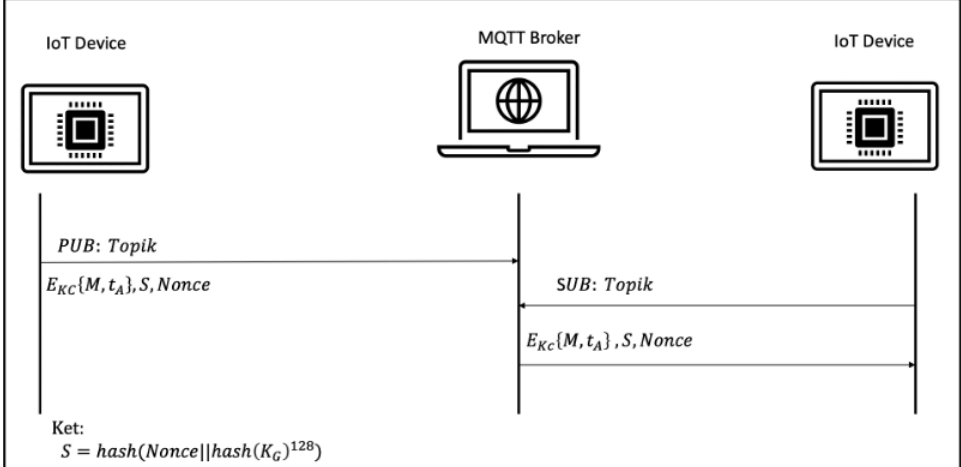
Figure 4. Communication